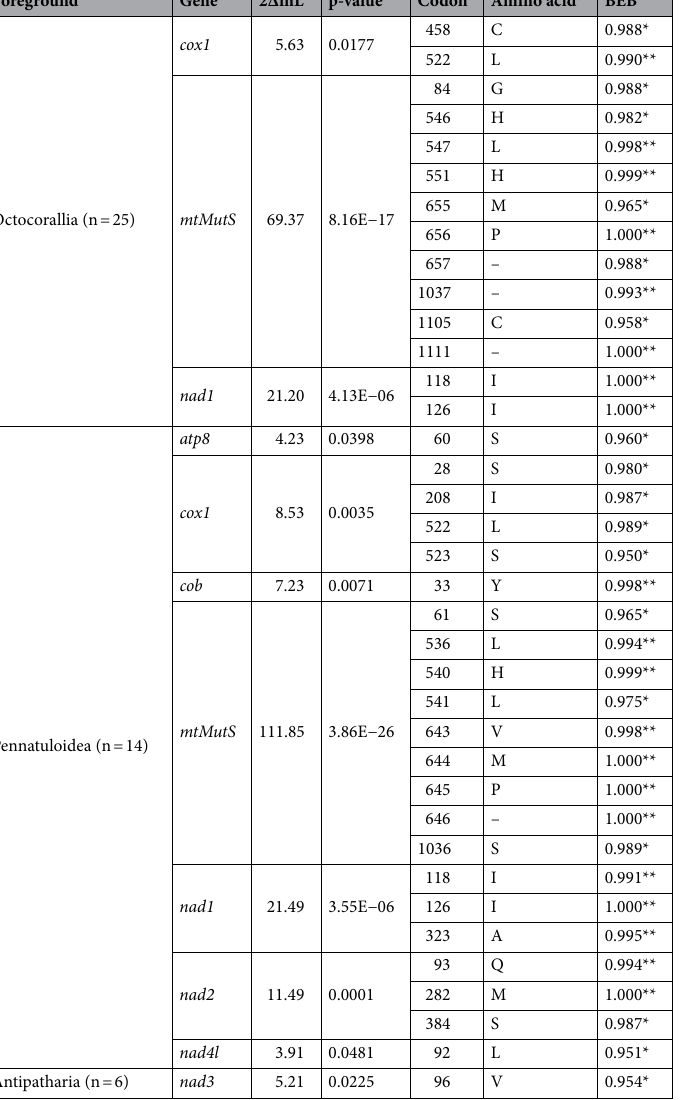
Table 2. Sites under positive selection in deep-sea corals as determined by BEB analysis within branch-site models (MA null vs. MA alternative ). Amino acid refers to IUPAC amino acid codes. *BEB > 95%, **> 99%. a Amino acids listed are in reference to first sequence in alignment; “–” denotes a gap at that